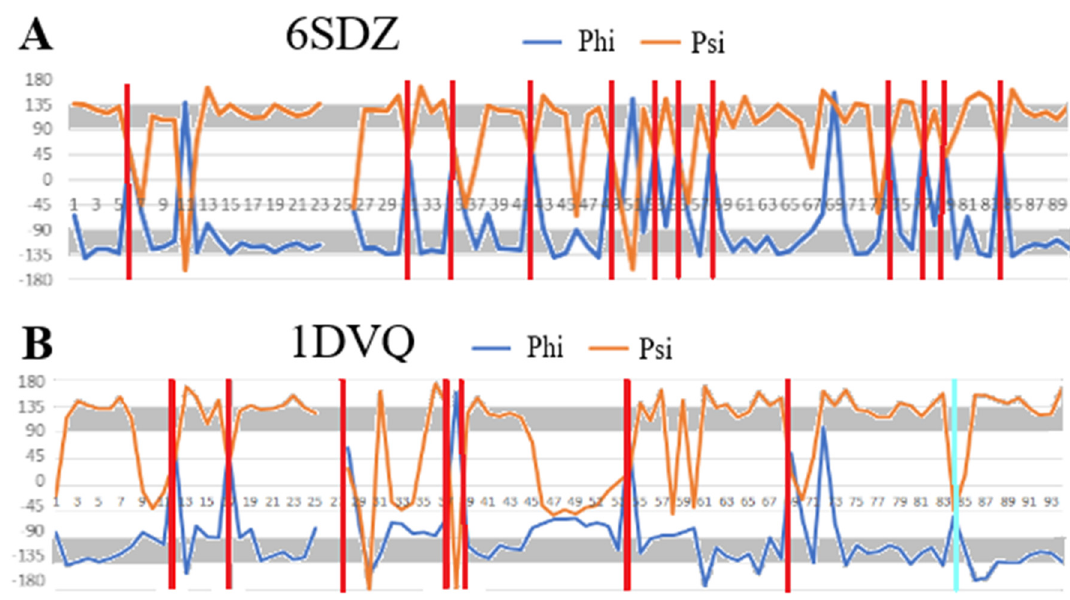
Figure 3. A comparison of the Phi and Psi angles for the ( A )—amyloid (6SDZ) chain and its ( B )—wild type form of transthyretin (1DVQ). Red diagram—Phi angles, blue diagram—Psi angles. Gray lines—distinguishing a β -structure conformation with the relation Psi = − Phi. Vertical lines: red—amino acid positions with L α conformation, cyan lines—amino acid positions with R α conformation. The shaded lines are to visualise the relation between Phi and Psi which is significantly more regular in amyloid